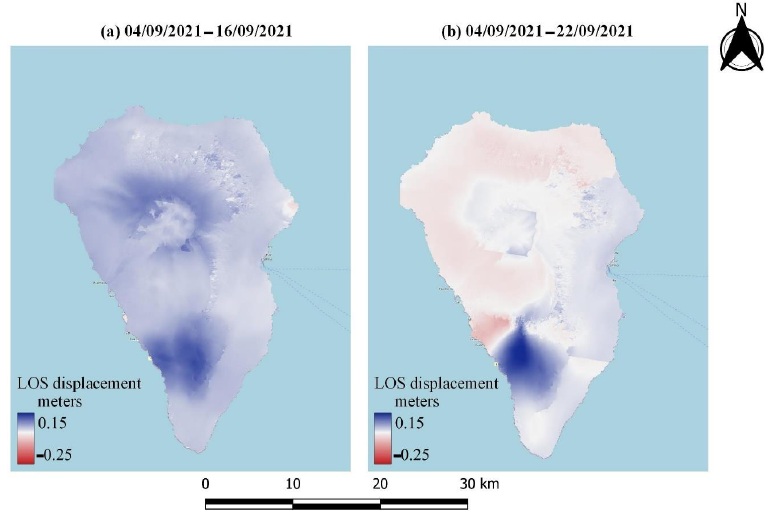
Figure 7. LOS displacement obtained by processing the Sentinel-1 descending imagery. ( a ) LOS displacement before the eruption. ( b ) LOS displacement after the eruption.